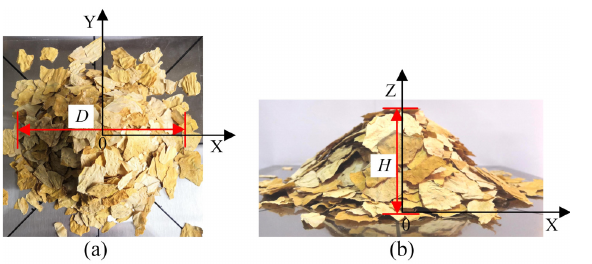
Figure 3. Tobacco strips stacking angle measurement for physical experiments. ( a ) X-Y view; ( b ) X-Z view.